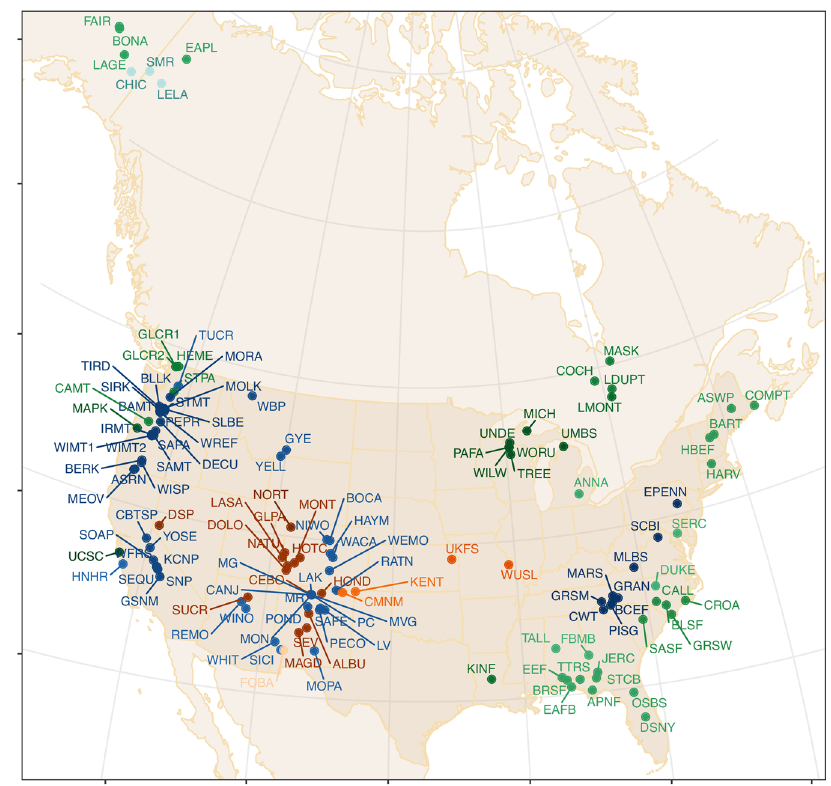
Fig. 1 Longitudinal sites in the MASTIF network. Colors match ecoregions in Fig. 3. Sites are listed by ecoregion in the Supplementary Data